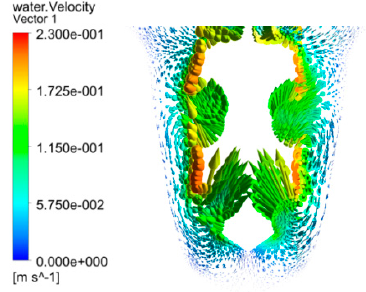
Figure 5. Velocity vector distribution diagram of electrolyte.